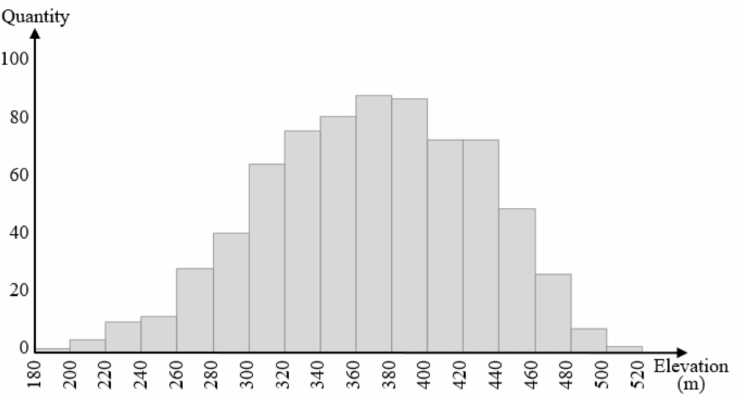
Figure 6. Histogram of elevations of saddles.